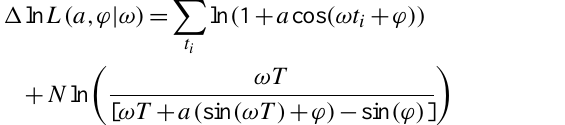
Figure 12. Main phases of seismic activity prior to earthquake and earthquake forecasting. 3